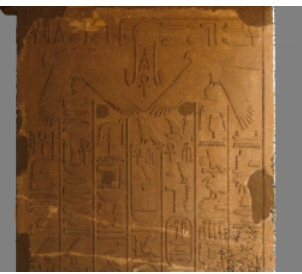
Figure 4 . Dense point cloud of relief 9, coexistence of cement mortar (1985) and plaster fillings